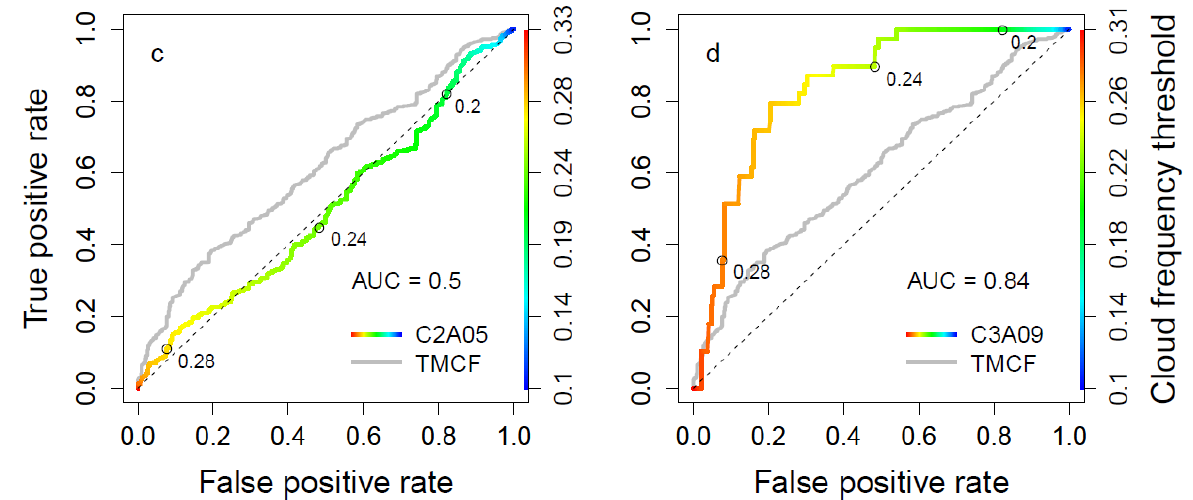
Figure 5. ROC curves showing the relationship between the four TMCF types C2A03 ( a ), C2A04 ( b ), C2A05 ( c ), and C3A09 ( d ) and daytime low cloud frequency in Taiwan. The additional grey ROC curve (AUC = 0.61) indicates the relationship between all TMCF types and low cloud frequency. The color bar indicates the respective cloud frequency threshold used for ROC calculation (blue = lowest frequency, red = highest